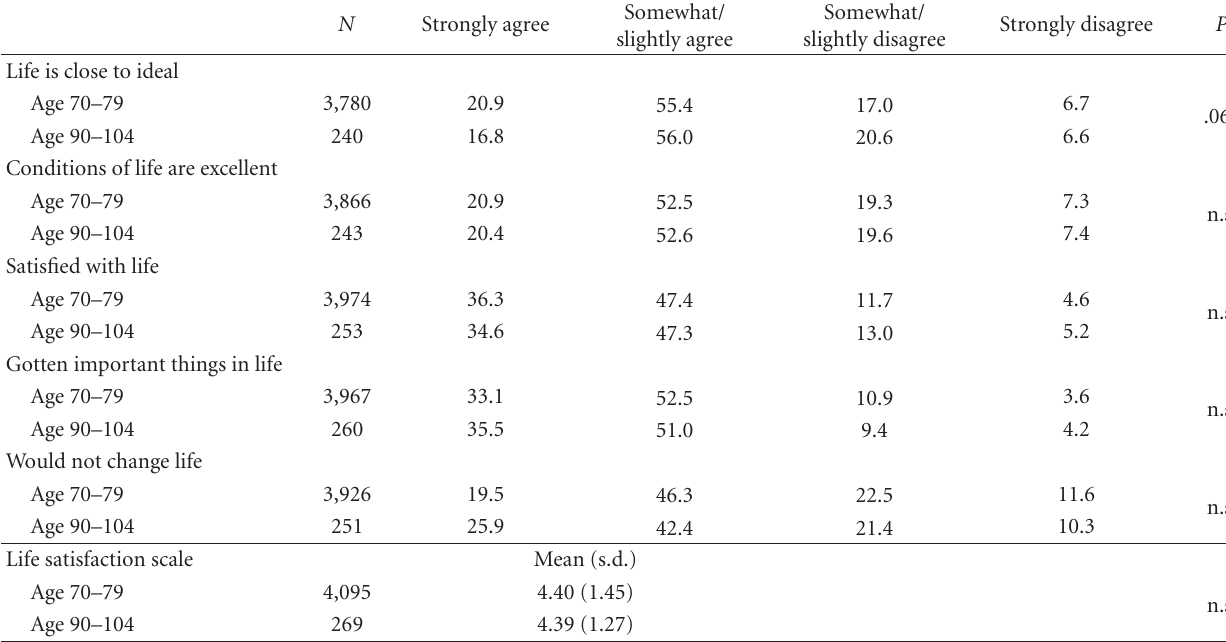
Table 4: Di ff erences in life satisfaction between the old (age 70–79) and the oldest-old (age 90–104), HRS 2006/2008. Somewhat/ Somewhat/ N Strongly agree Strongly disagree slightly agree slightly disagree